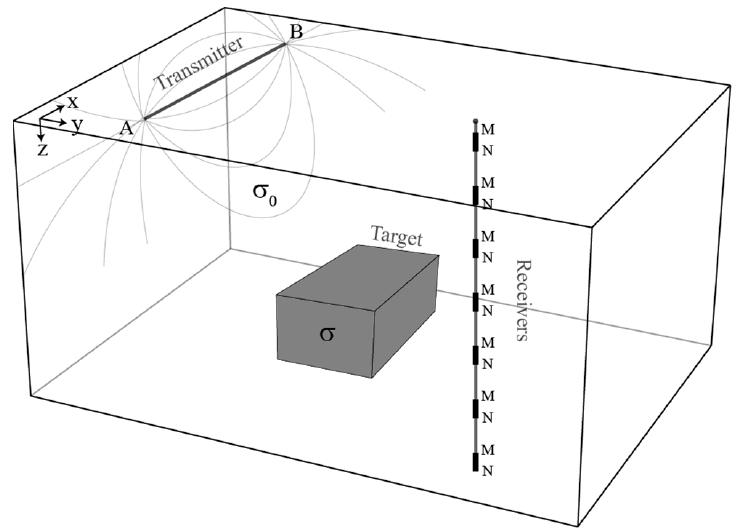
Figure 1. SBTEM survey con fi guration.